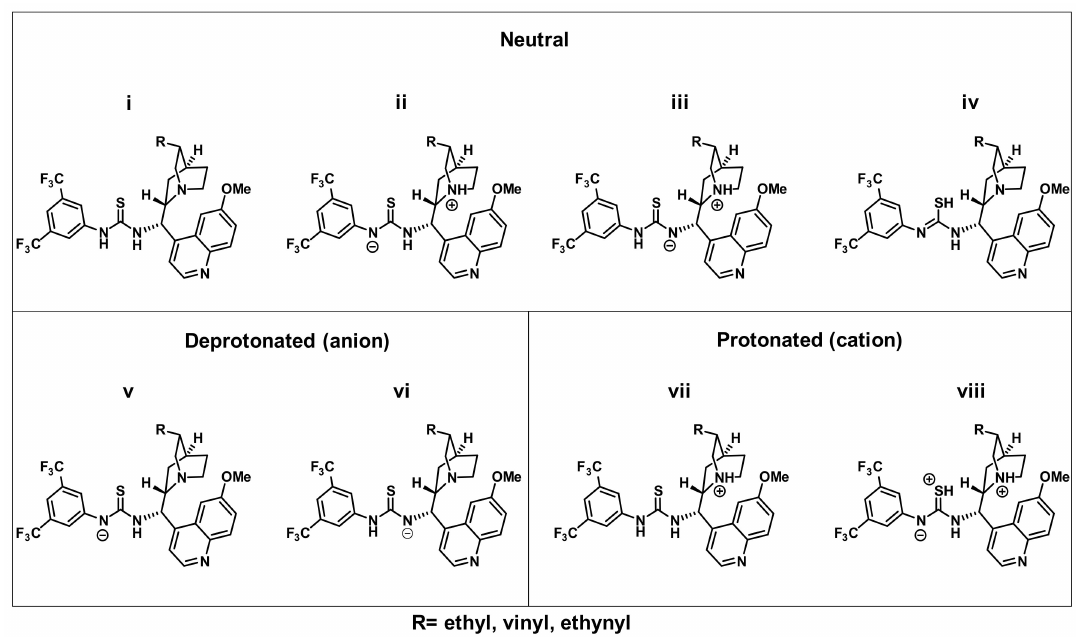
Figure 4. The significant neutral, deprotonated, and protonated tautomer forms of thioureas. Table 4. Relative Gibbs free energies (kJ · mol − 1 ) of the energetically lowest-lying tautomers of thioureas (HQ-TU, Q-TU, DQ-TU) and their deprotonated anion and protonated cation forms in THF. Compound